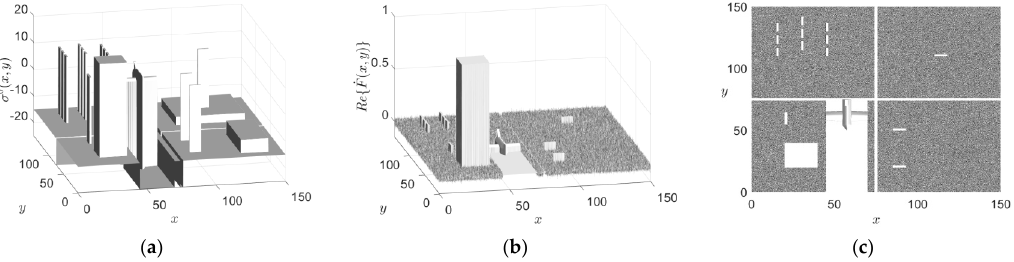
Figure 4. Characteristics of the test surface: ( a ) the radar cross section, ( b ) the real part of the complex scattering coefficient, ( c ) the top projection of Re{F(x,y)} . → (cid:12) (cid:12) Y ( r ) To test the simulation, the optimal output effect (cid:12) (cid:12) was first obtained in an → → rameters: θ x ( r , t ) = 0, θ y ( r , t ) = 0, f 0 = 10 GHx, H = 10 km, surface size 150 m × 150 m,